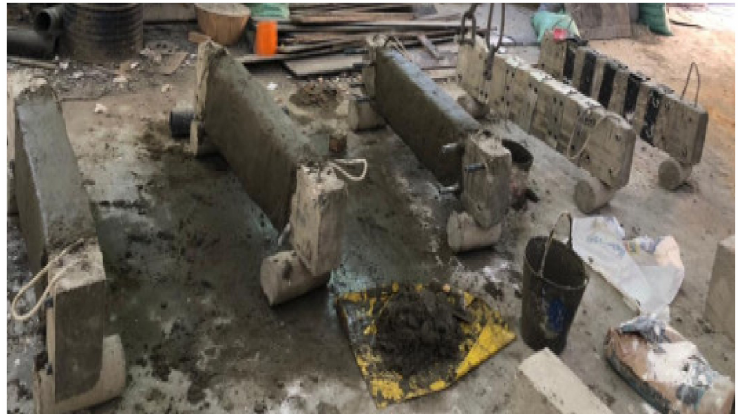
Figure 6. Preparing beam B4-1SM.